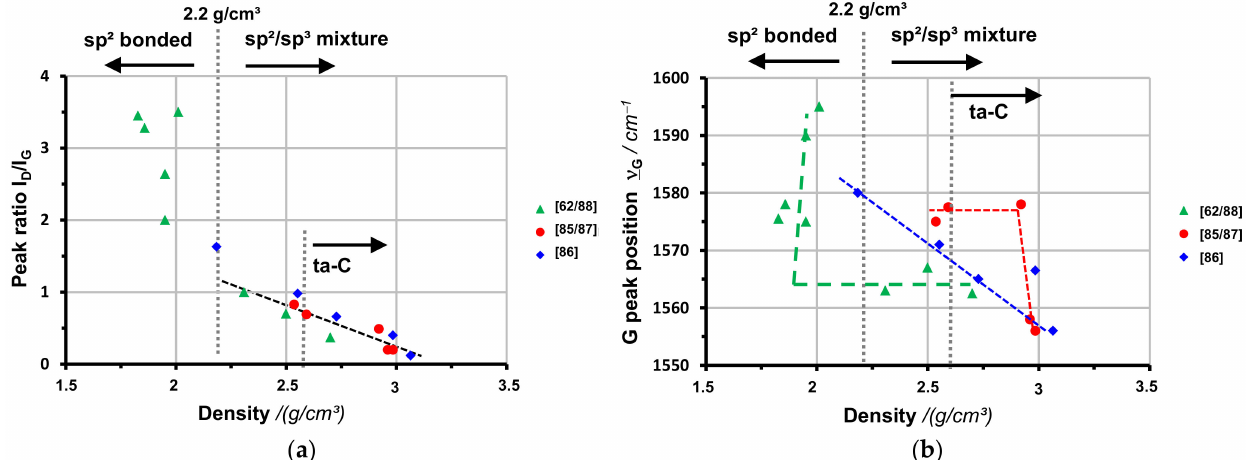
Figure 25. Relationship between the Raman characteristics and the density for carbon films deposited at different temperatures. Data from [62,88] (Laser-Arc deposition with ion energies of 80–90 eV), from [85,87] (filtered arc deposition with ion energies of 60 eV) and from [86] (filtered arc deposition with ion energies of 80 eV). Density for [85,87] calculated from the sp 3 fraction in Figure 18 with Equation (1). ( a ) Raman peak ratio. ( b ) G peak position.